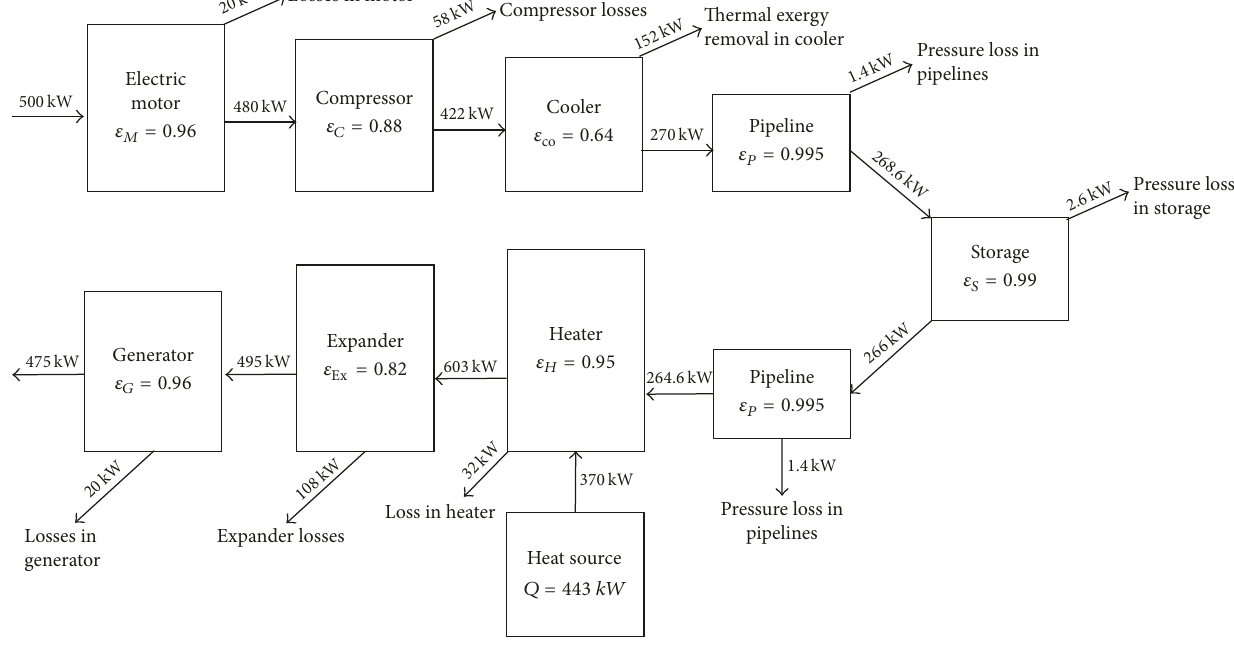
Table 3: Thermodynamic properties and mass flow rates of air at different state points for adiabatic OCAES system (see Figure 2 for state points).